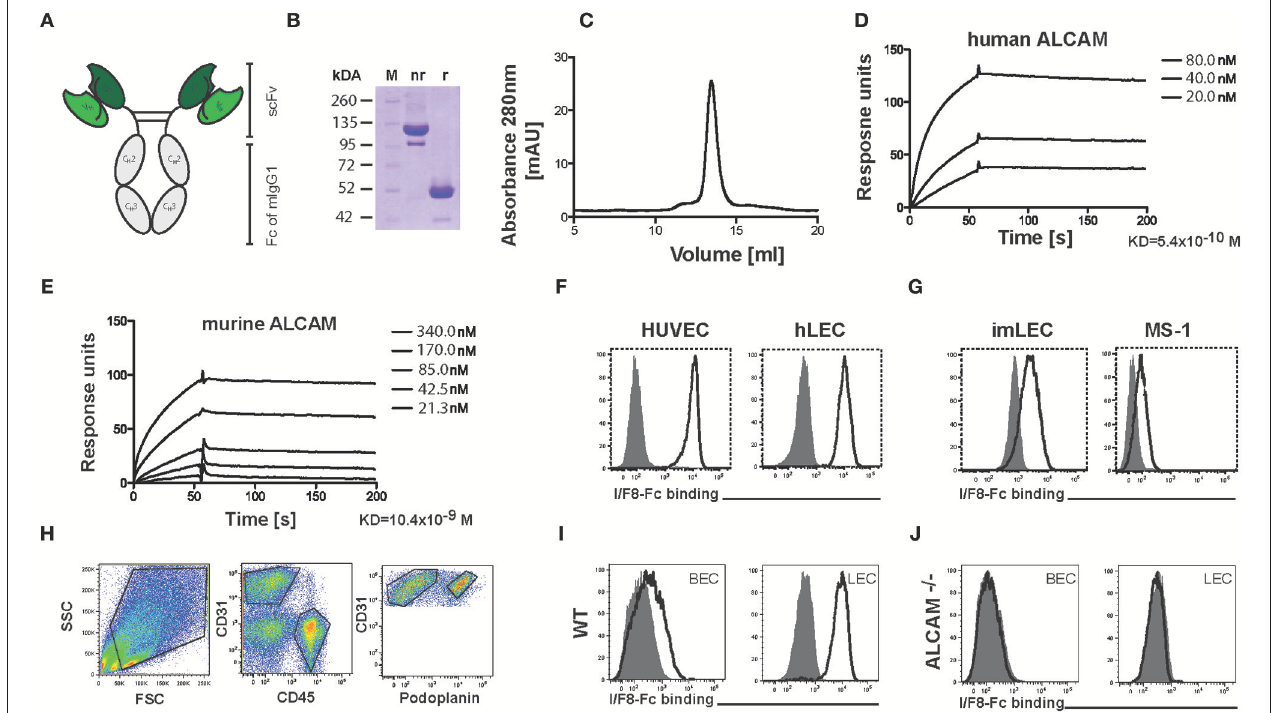
FIGURE 1 | Production and characterization of the ALCAM-blocking antibody I/F8-Fc. (A) Schematic representation of the homodimeric I/F8-Fc antibody, consisting of scFv IF/8 fused to the Fc portion of murine IgG 1 . (B) SDS-PAGE of I/F8-Fc under non-reducing (nr) and reducing (r) conditions. Expected molecular weight: 51 kDa under reducing conditions. (C) In FPLC I/F8-Fc elutes as a homodimer. (D,E) Surface plasmon resonance profiles of purified I/F8-Fc on micro sensor chips coated with (D) human and (E) murine ALCAM. (F,G) FACS analysis reveals I/F8-Fc binding to (F) human and (G) murine endothelial cell lines. (H–J) Analysis of I/F8-Fc specificity by FACS analysis performed on single cell suspensions generated from murine lungs of WT and ALCAM − / − mice. (H) FACS gating strategy for differentiating BECs from LECs. Single-cell suspensions from enzymatically digested lung tissue were stained for CD45, CD31, and podoplanin. BECs and LECs were identified, by gating on CD45 − CD31 + podoplanin − (BECs) or CD45 − CD31 + podoplanin + (LECs) cells. (I,J) I/F8-Fc stains BECs (CD45 − CD31 + podoplanin − ) and LECs (CD45 − CD31 + podoplanin + ) in lung single-cell suspension derived from (I) WT mice but not from (J) ALCAM − / − mice. Black lined histogram: I/F8-Fc, shaded histogram: KSF-Fc control. Representative data from one out of four similar experiments are shown in (F–J)